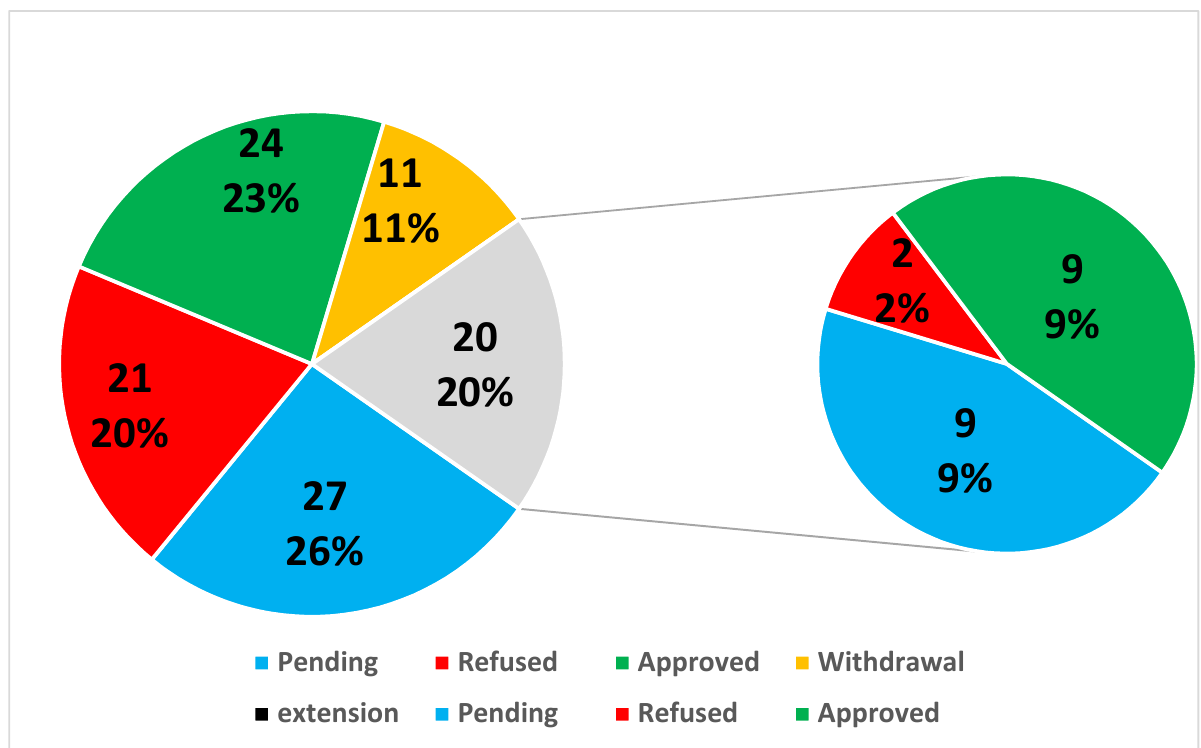
Figure 1. Total of the basic substance applications (BSA) and extensions presented by the results (%).